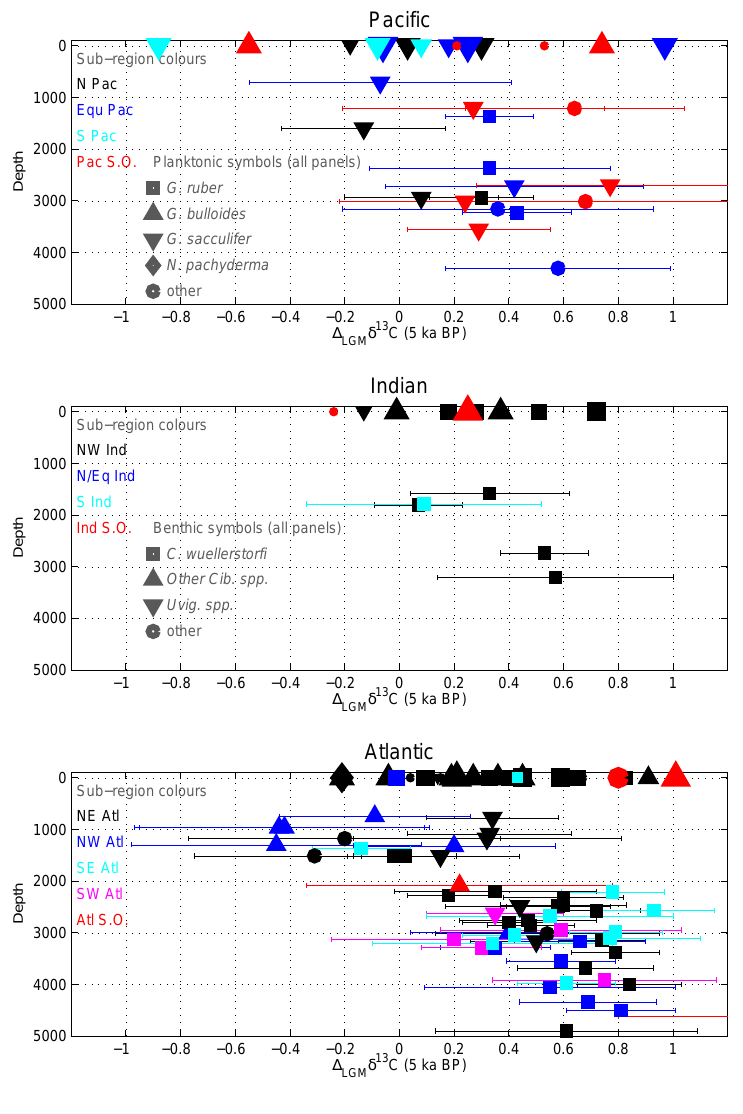
Fig. 11. 5ka 1 LGM δ 13 C time-slice, with 2 σ error bars on benthic